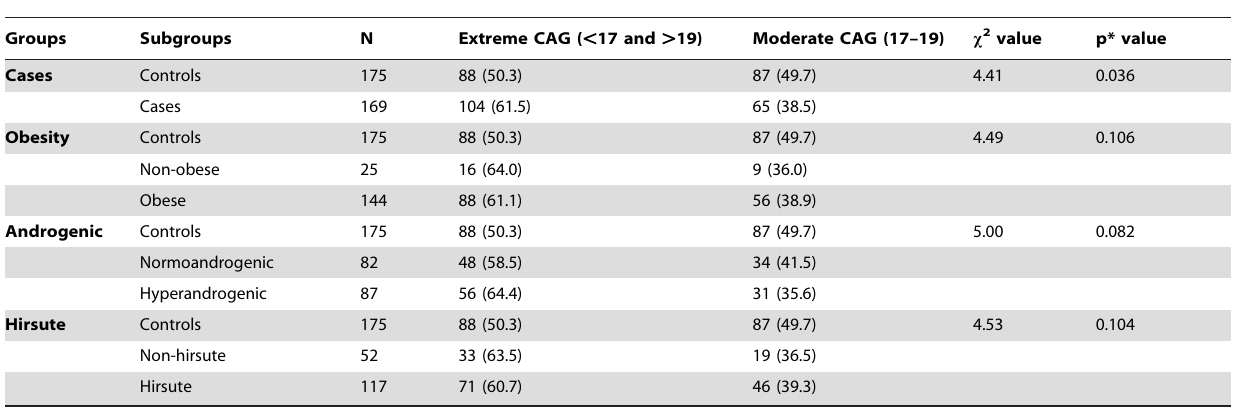
Table 4. Frequency distribution (%) of CAG bi-allelic mean length in two CAG categories (extreme and moderate).